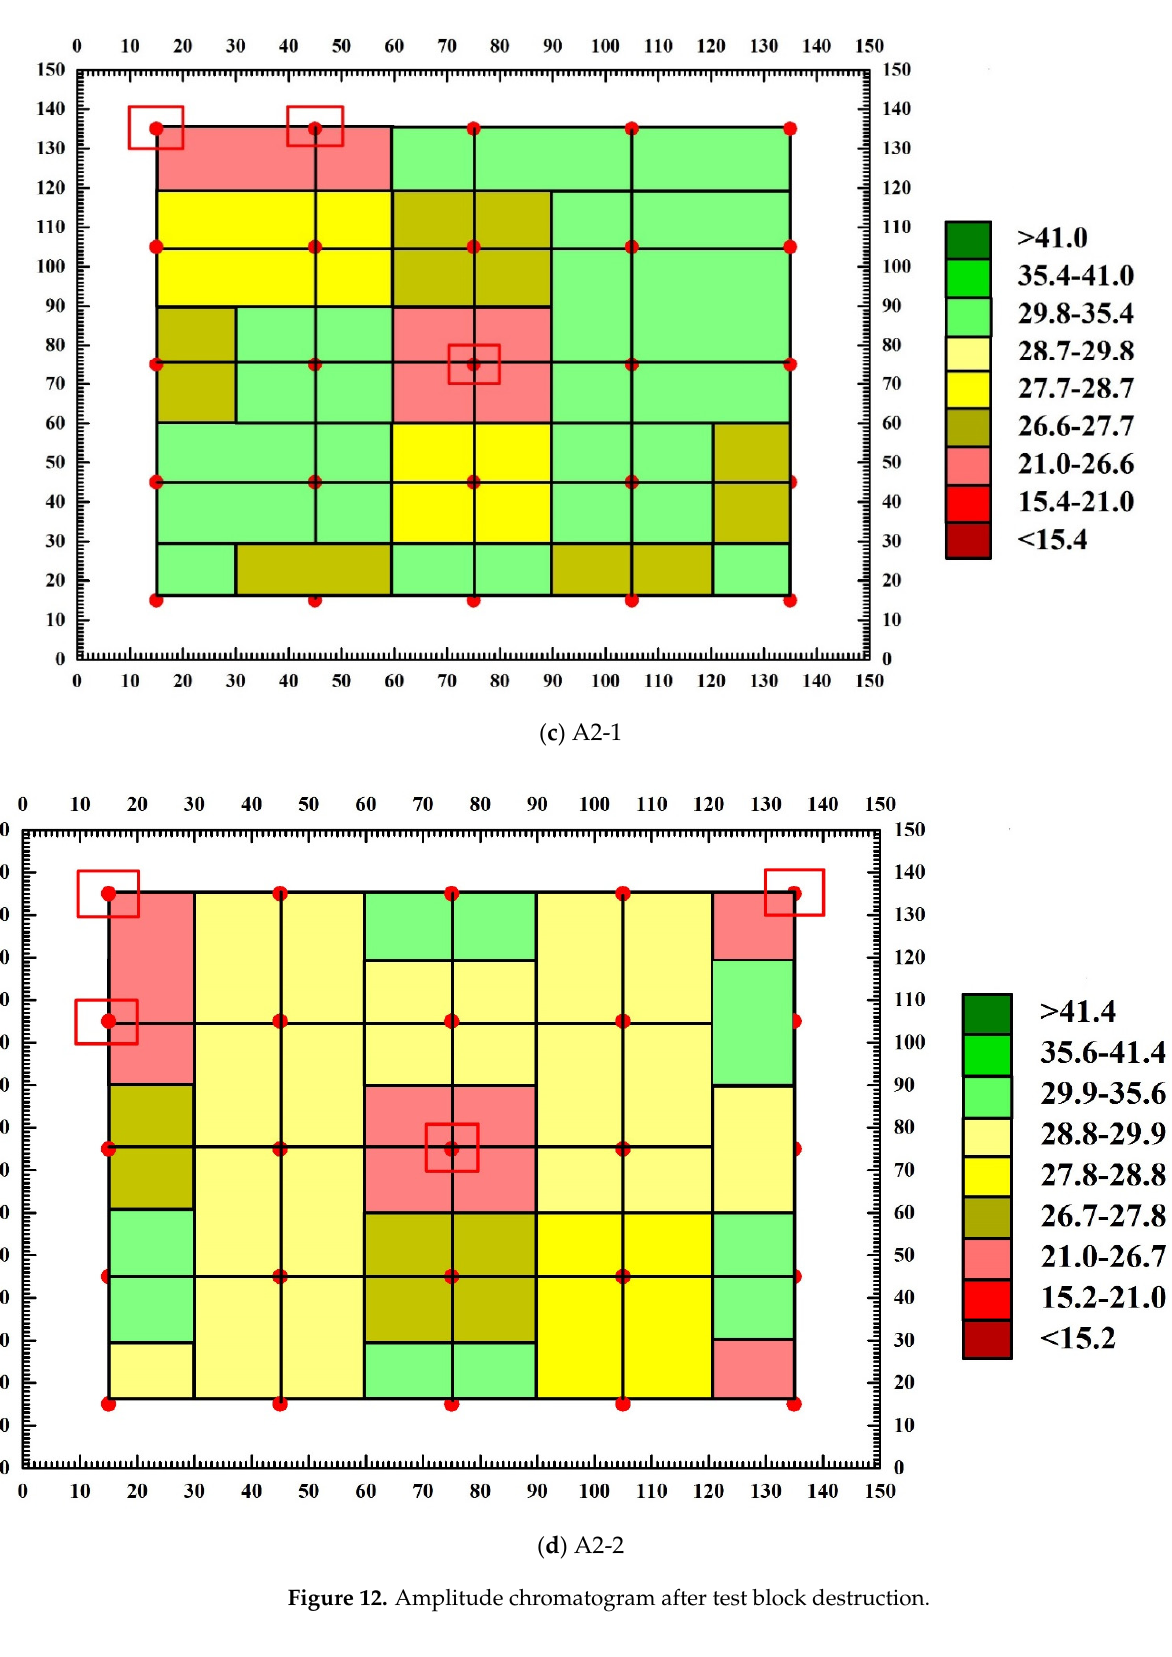
Figure 12. Amplitude chromatogram after test block destruction.